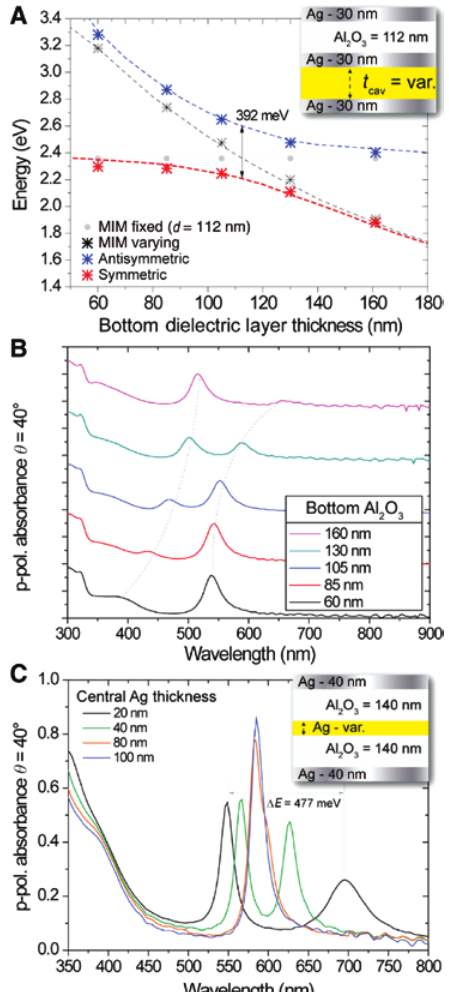
Figure 2: Mode splitting in a MIMIM double cavity. (A) Mode anticrossing in a MIMIM system with 30 nm Ag layers and 112 nm Al O as top dielectric layer, whereas the thickness of the 2 3 bottom dielectric layer is varied. Experimentally measured data is shown by stars and the simulated dispersion via SMM is shown by dashed lines. The gray markers (experimental) and lines (SMM simulations) show the case of noninteracting cavities. (B) Absorbance spectra measured in p-polarization and obtained as (1-transmittance- reflectance) for the five MIMIM structures with different dielectric bottom layer thickness displayed in (A). (C) Ellipsometrically measured p-polarized absorbance curves for different thickness of the central layer. For a MIMIM with 20 nm central Ag layer, we obtained a mode splitting of 447 meV that corresponds to about six times the linewidth of the antisymmetric mode (see also Figure S2 in the SI for MIMIM systems with other metal layer